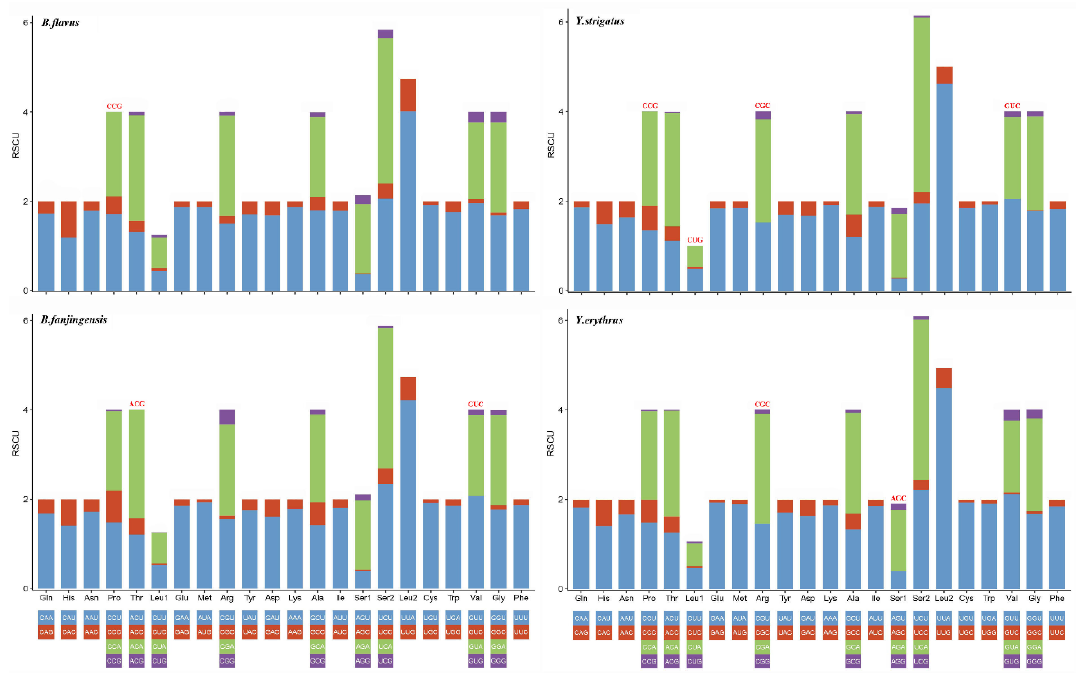
Figure 3. Relative synonymous codon usage in the protein-coding genes of Bambusicaliscelis flavus , B. fanjingensis , Youtuus strigatus , and Y. erythrus mitogenomes. Codon families are indicated below the X-axis. The color of the codon family below the X-axis corresponds to the color above the X-axis. The stop codon is not given. Codons absent in mitochondrial genomes are shown at the top of columns.